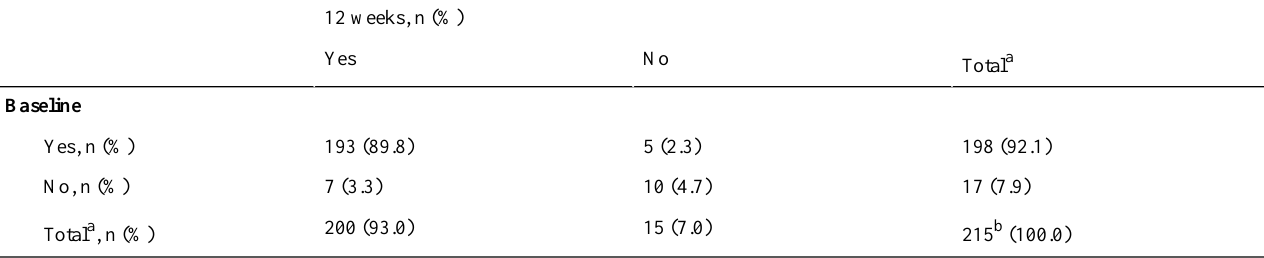
Table 5. Would you like to completely stop smoking cigarettes (N=215)? Select one. 12 weeks, n (%)